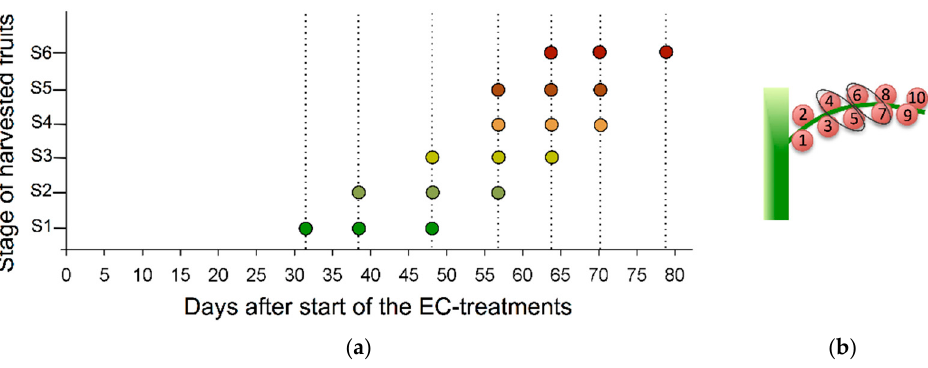
Figure 6. ( a ) Schematic overview of the harvest strategy, which was executed for each individual EC-treatment. Seven harvest moments, represented by the dashed lines, were considered. At each harvest moment, specific stages of fruit development were harvested, as indicated on the Y-axis and represented by the colored circles (coloring reflects developmental stage). Hereby, six stages of fruit development and ripening were defined ( i.e. , from S1 to S6) based on days after anthesis; and ( b ) Schematic representation of the sampling and pooling strategy. Hereby the fruits that were preferred for sampling are indicated. Fruits within a same circle were